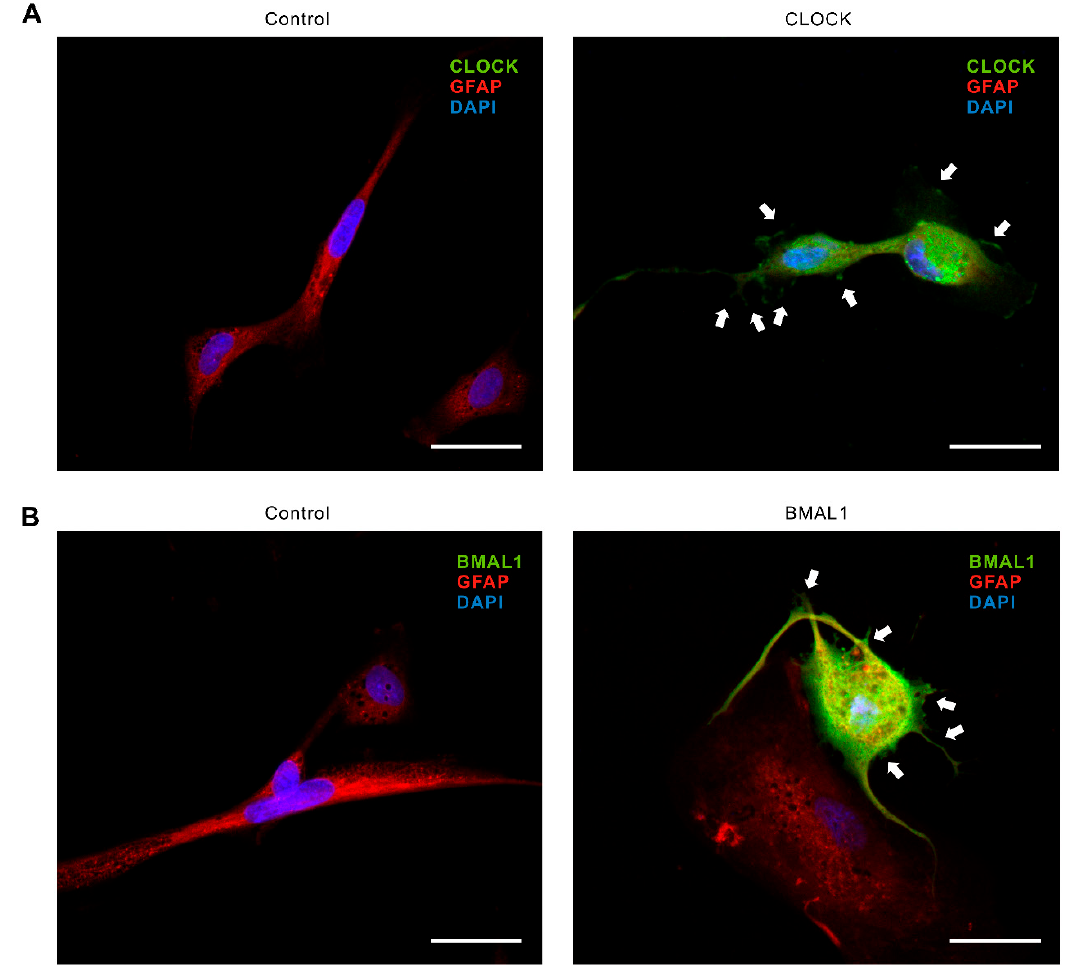
Figure 3. The elevation of CLOCK and BMAL1 contributes to the functional impairment by reduction in GFAP-positive filaments in human astrocytes. ( A ) Representative immunofluorescence images of CLOCK expression in control and CLOCK-overexpressing (CLOCK) human astrocytes showing CLOCK (green) and GFAP (red) ( n = 10 per group). DAPI-stained nuclei are shown in blue. The shortness and shrinkage of GFAP-positive filaments were indicated (white arrows). Scale bars, 20 μ m. ( B ) Representative immunofluorescence images of BMAL1 expression in control and BMAL1- overexpressing (BMAL1) human astrocytes showing BMAL1 (green) and GFAP (red) ( n = 10 per group). DAPI-stained nuclei are shown in blue. The shortness and shrinkage of GFAP-positive filaments were indicated (white arrows). Scale bars, 20 μ m. ( C ) Representative immunoblot analysis for GFAP (left) and quantification for GFAP protein levels (right) in control and CLOCK- overexpressing (CLOCK) human astrocytes. For immunoblots, β -actin was used as loading control. Data are representative of three independent experiments. Data are mean ± SEM. * p < 0.05 using the two-tailed Student’s t -test. ( D ) Representative immunoblot analysis for GFAP (left) and quantification